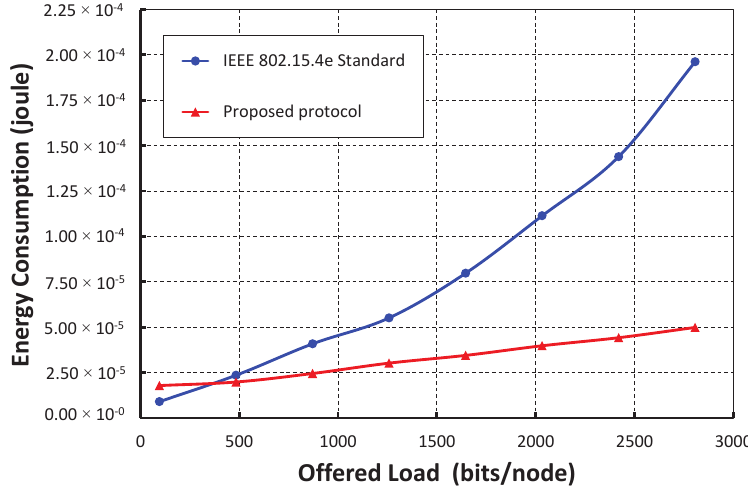
Figure 11. Comparison of the energy consumption of our protocol with the IEEE 802.15.4e standard.